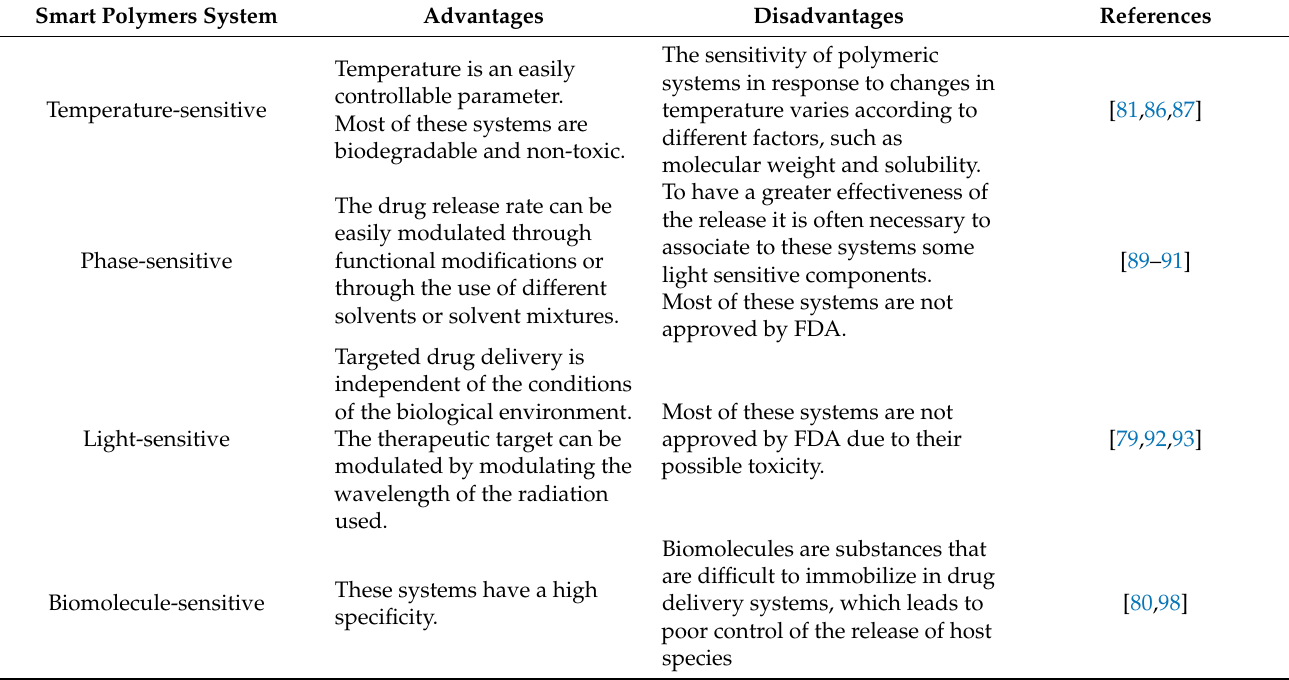
Table 1. Advantages and disadvantages of using the various smart polymer platforms. Smart Polymers